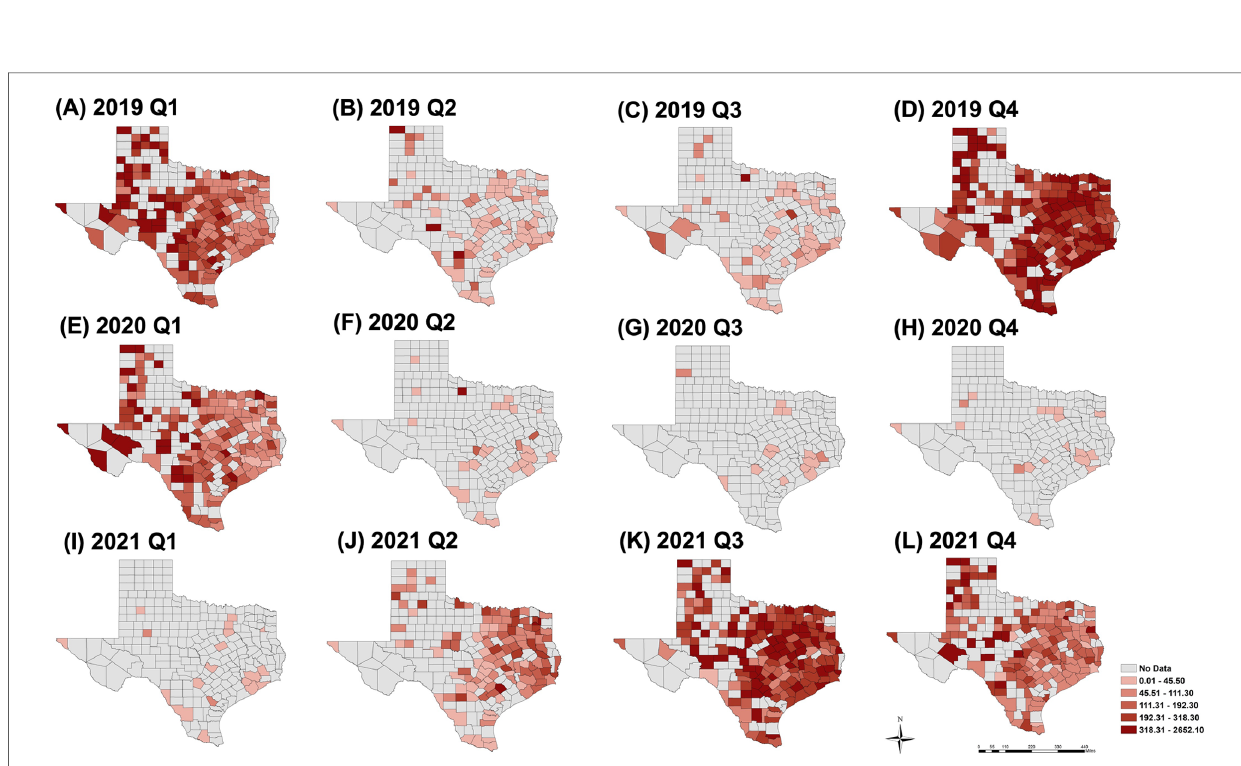
FIGURE 4 Spatial distribution of hospitalization rates per 100,000 persons at the county level for 2019 Q1 to 4 ( A – D ), 2020 Q1 to 4 ( E – H ) and 2021 Q1 to 4 ( I – L ). Year 2019 represents a “ typical ” season, years 2020 and 2021 show the impact of COVID-19 on the spatial